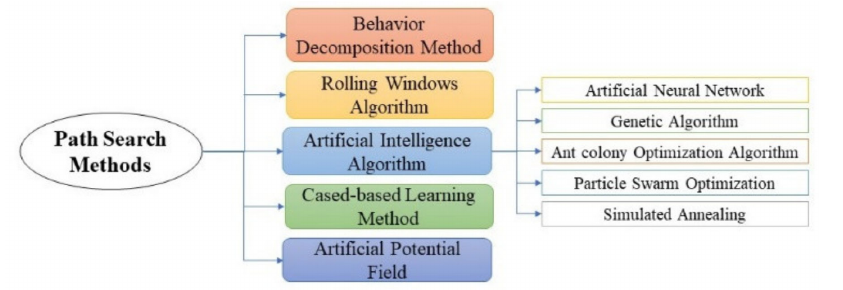
Figure 2. Path search methods in the motion planning